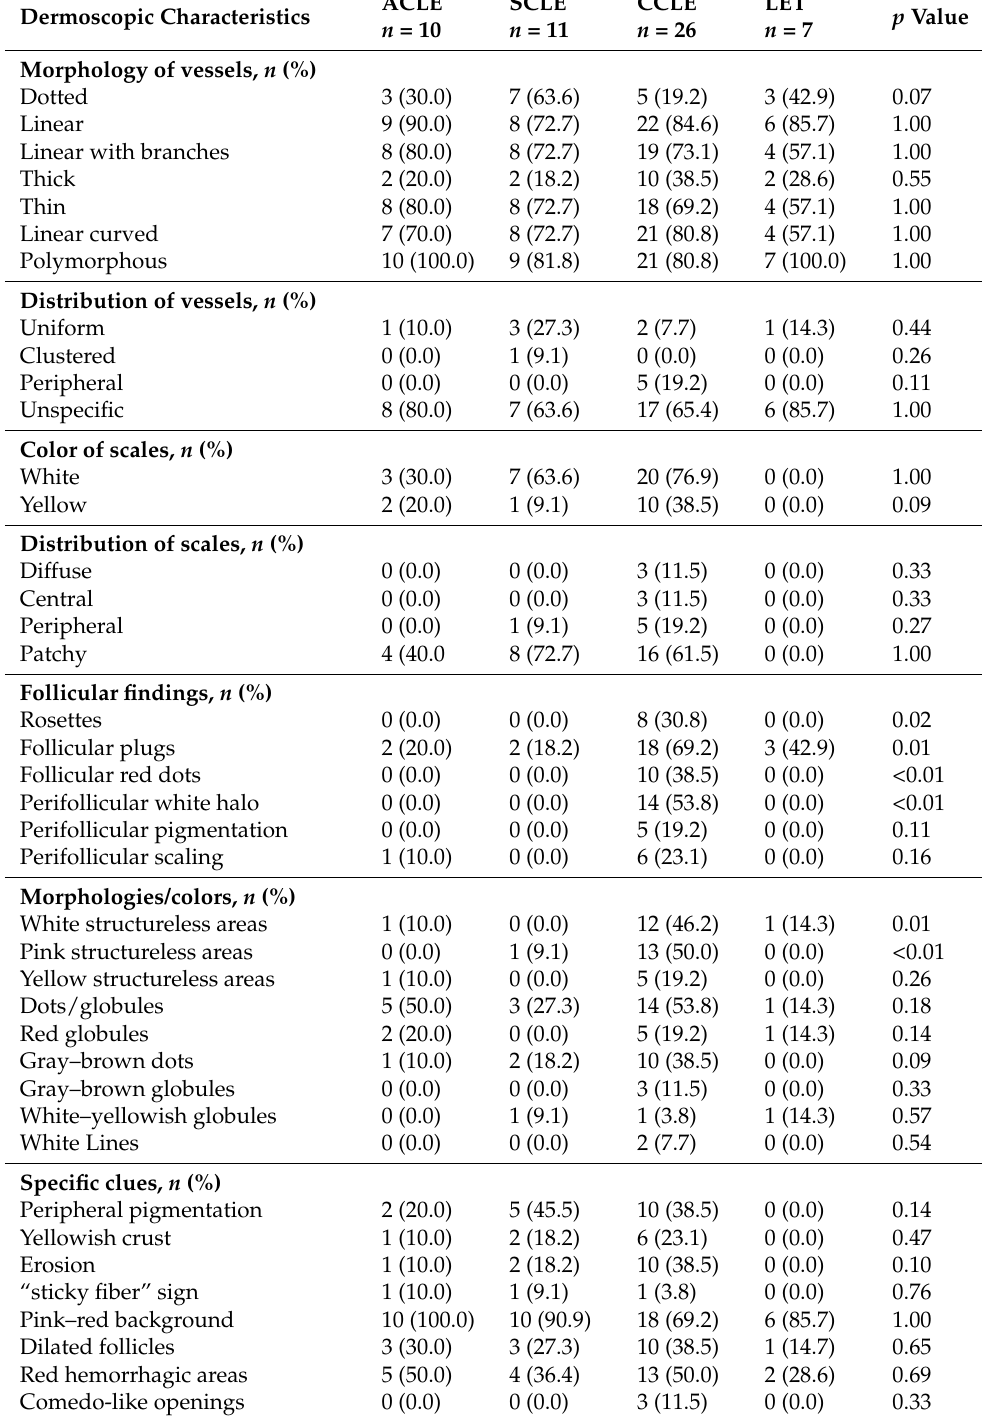
Table 2. Dermoscopic findings in cutaneous lupus erythematosus (CLE), by clinical subtype (ACLE— cutaneous lupus erythematosus; SCLE—chronic cutaneous lupus erythematosus; CCLE—chronic cutaneous lupus erythematosus; LET—lupus erythematosus tumidus; n —number of